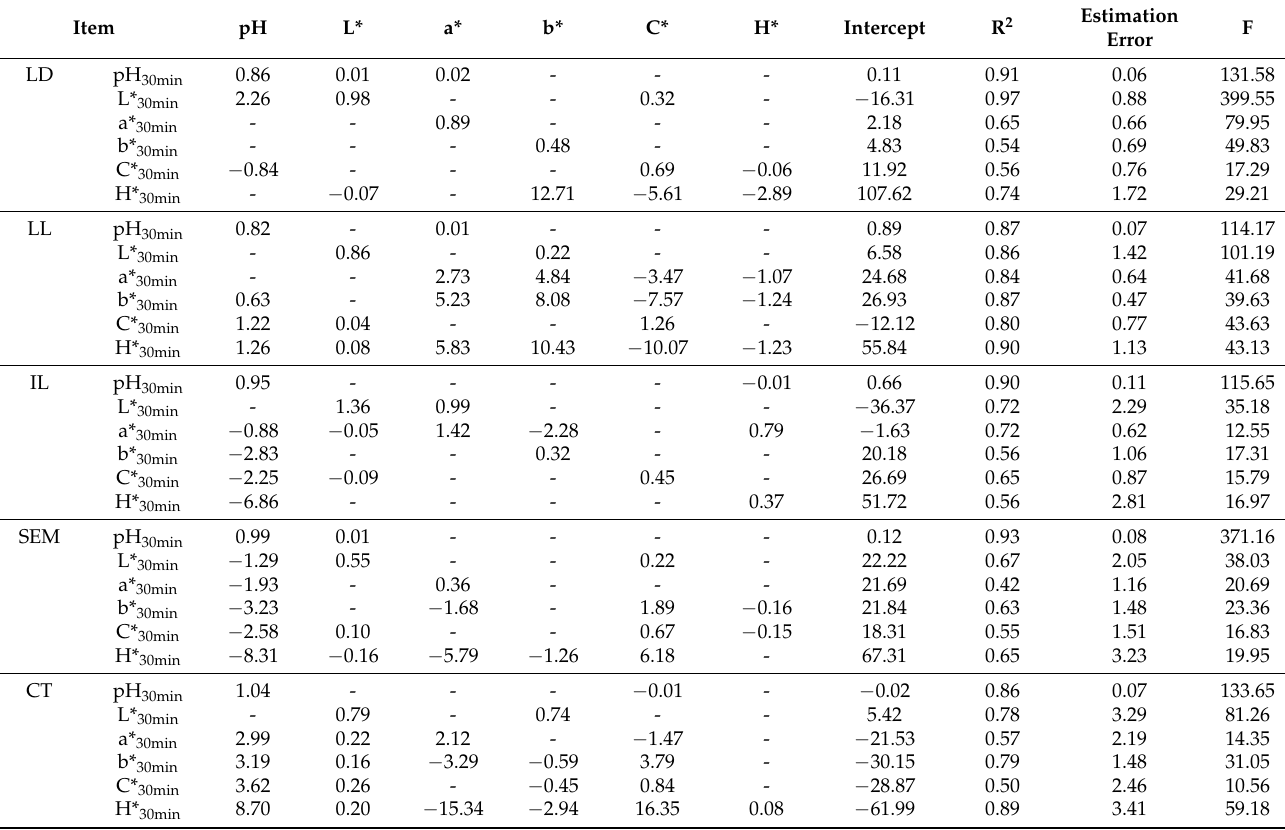
Table 3. Regression equations estimating pH and color parameters after 30 min bloom time on the basis of fresh samples and evaluation for each muscle